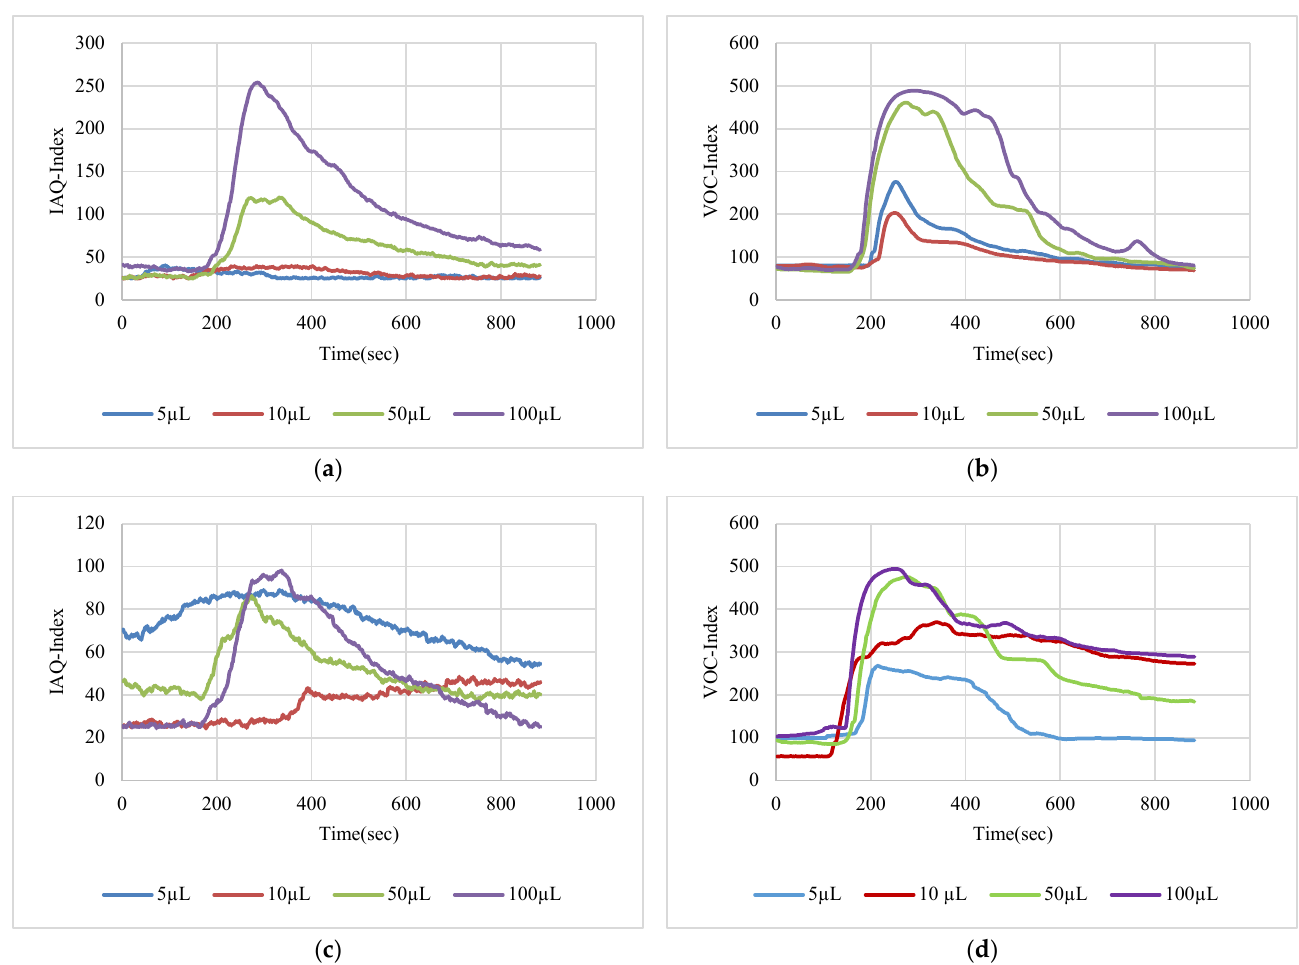
Figure 14. Test results for diethyl ether: ( a ) BME688 40 cm, ( b ) SGP41 40 cm, ( c ) BME688 100 cm, ( d ) SGP41 100 cm.